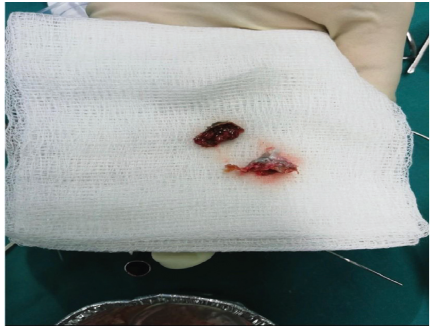
Figure 1: Postoperative procedure revealed thick keratinous plug mixed with